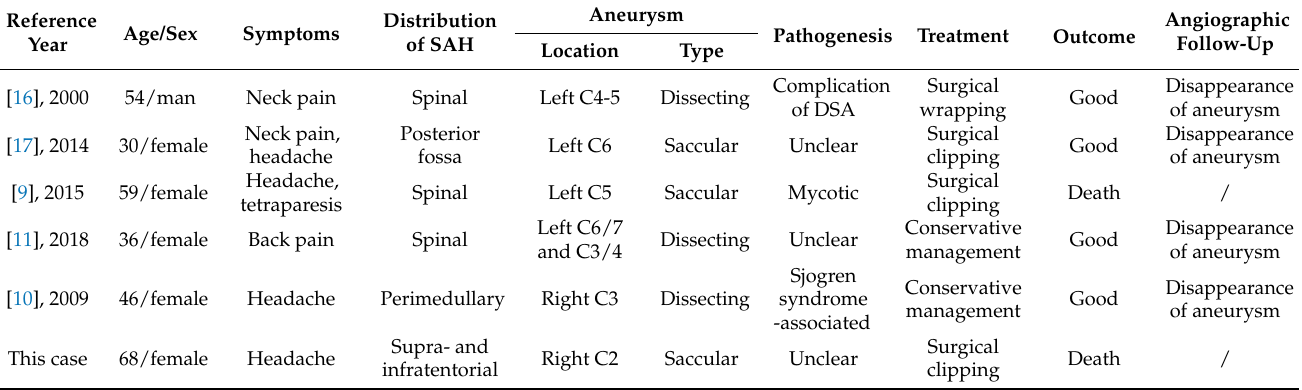
Table 1. Clinical characteristics of aneurysm arising from cervical radiculomedullary